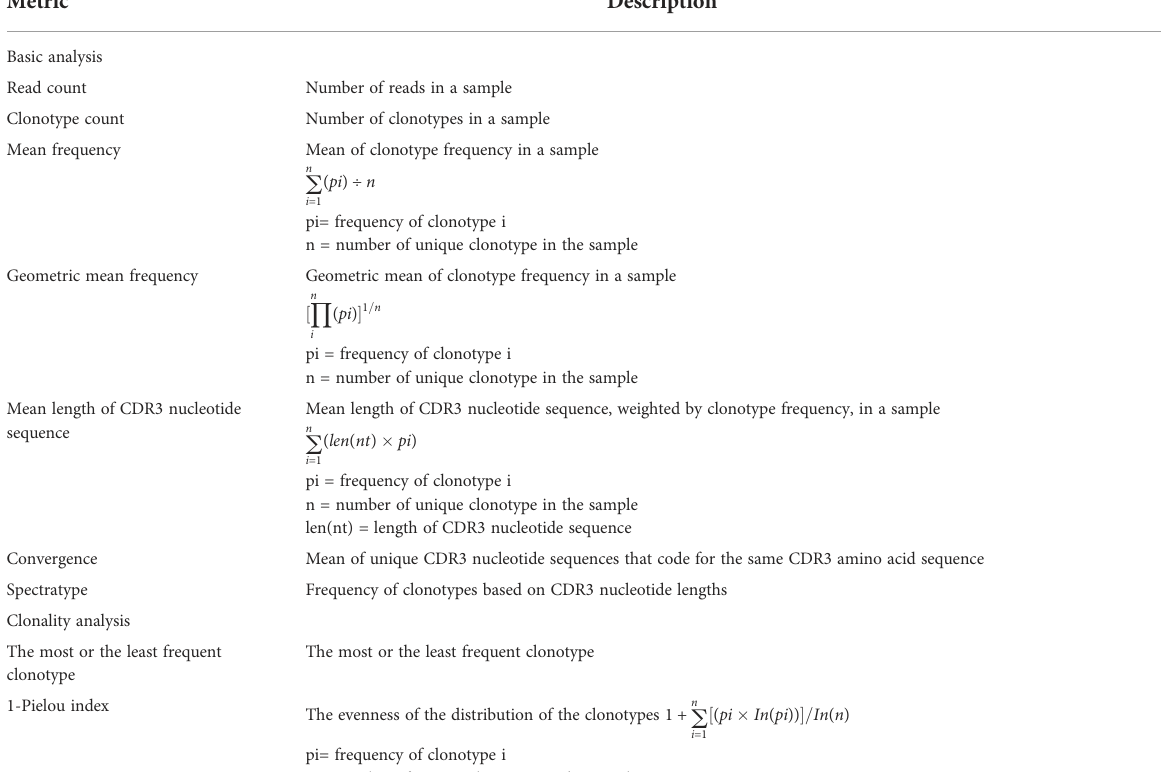
TABLE 1 TCR repertoire analysis functions in